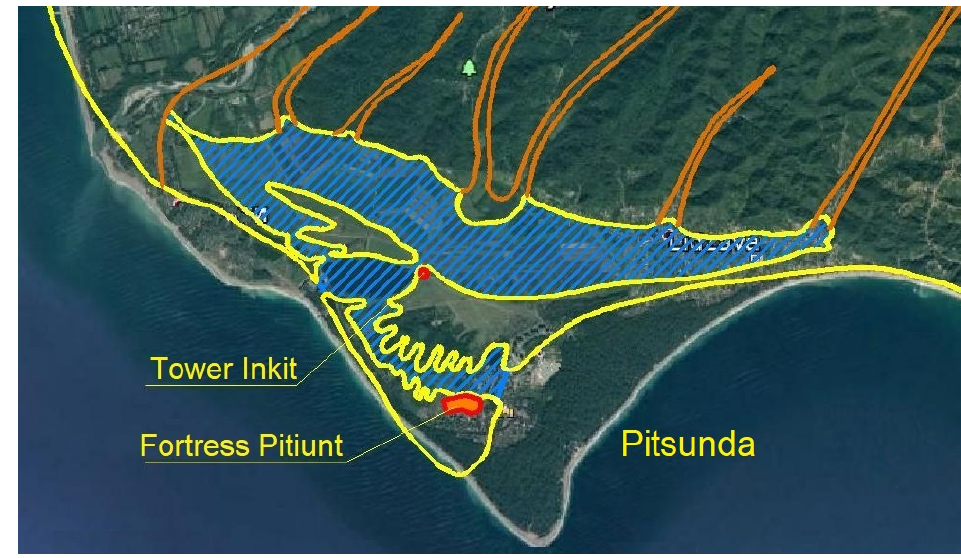
Figure 2. The outlines of the coastline of the Pitsunda Cape in the first century AD.